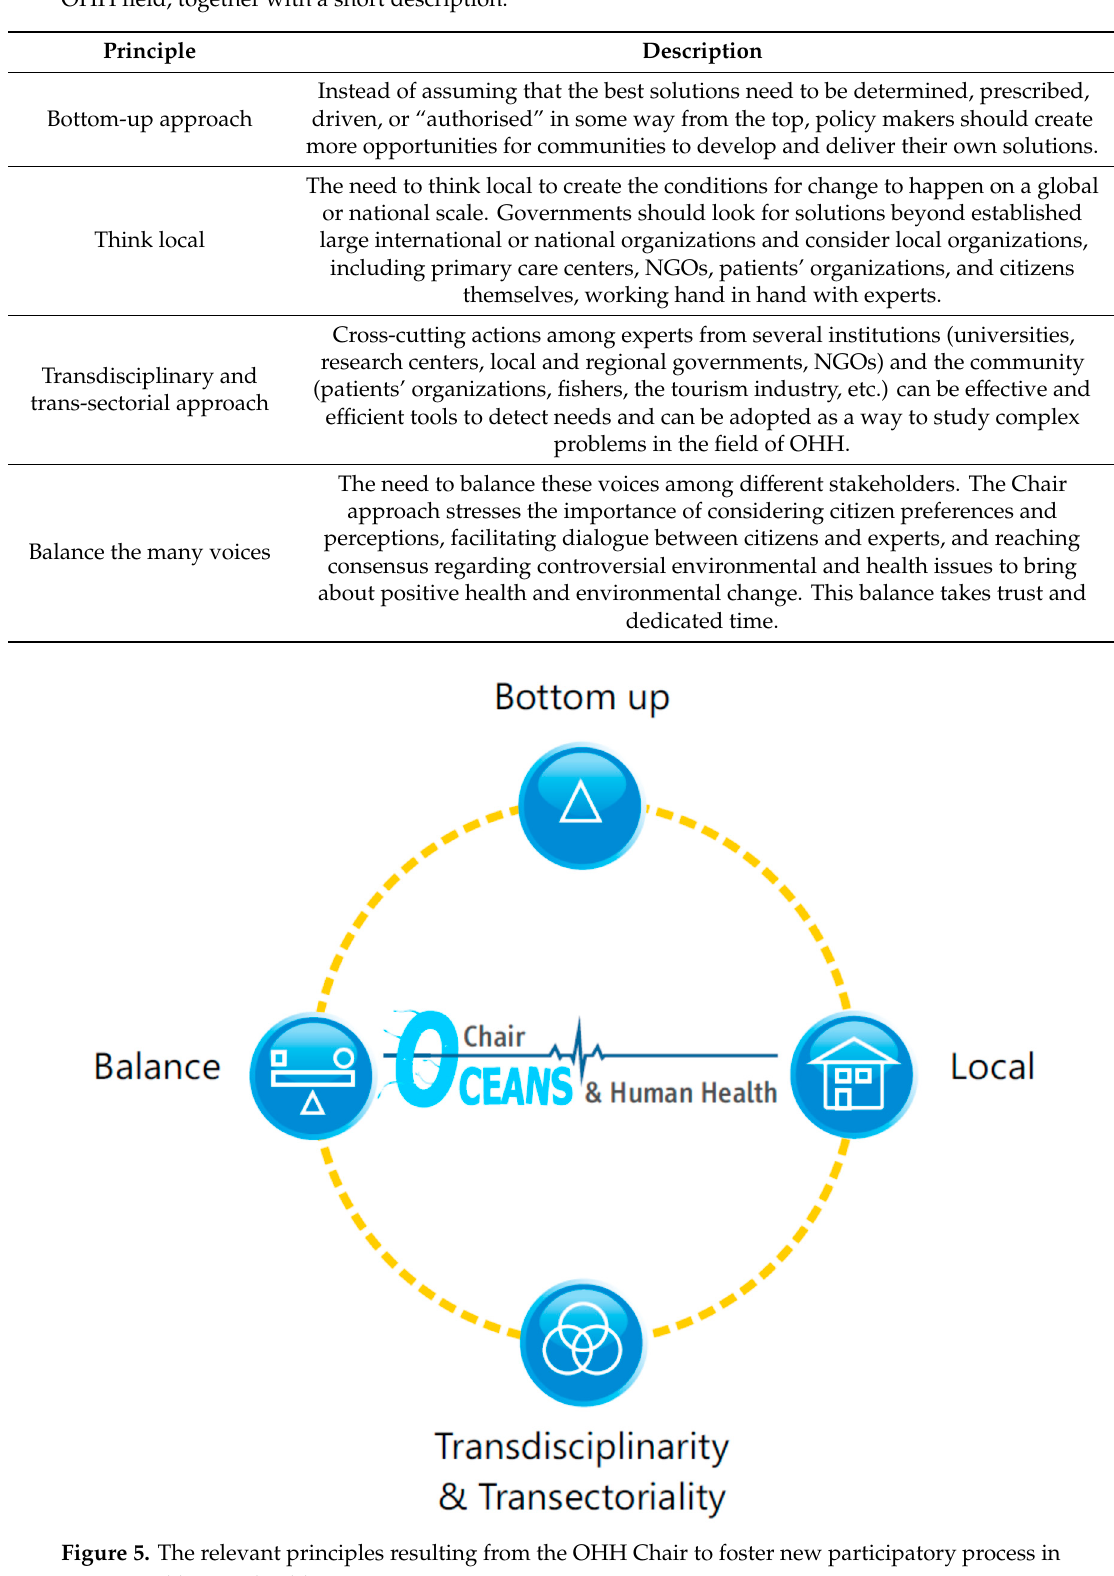
Table 1. The basic principles established by the Chair to ensure better participatory processes in the OHH field, together with a short description.